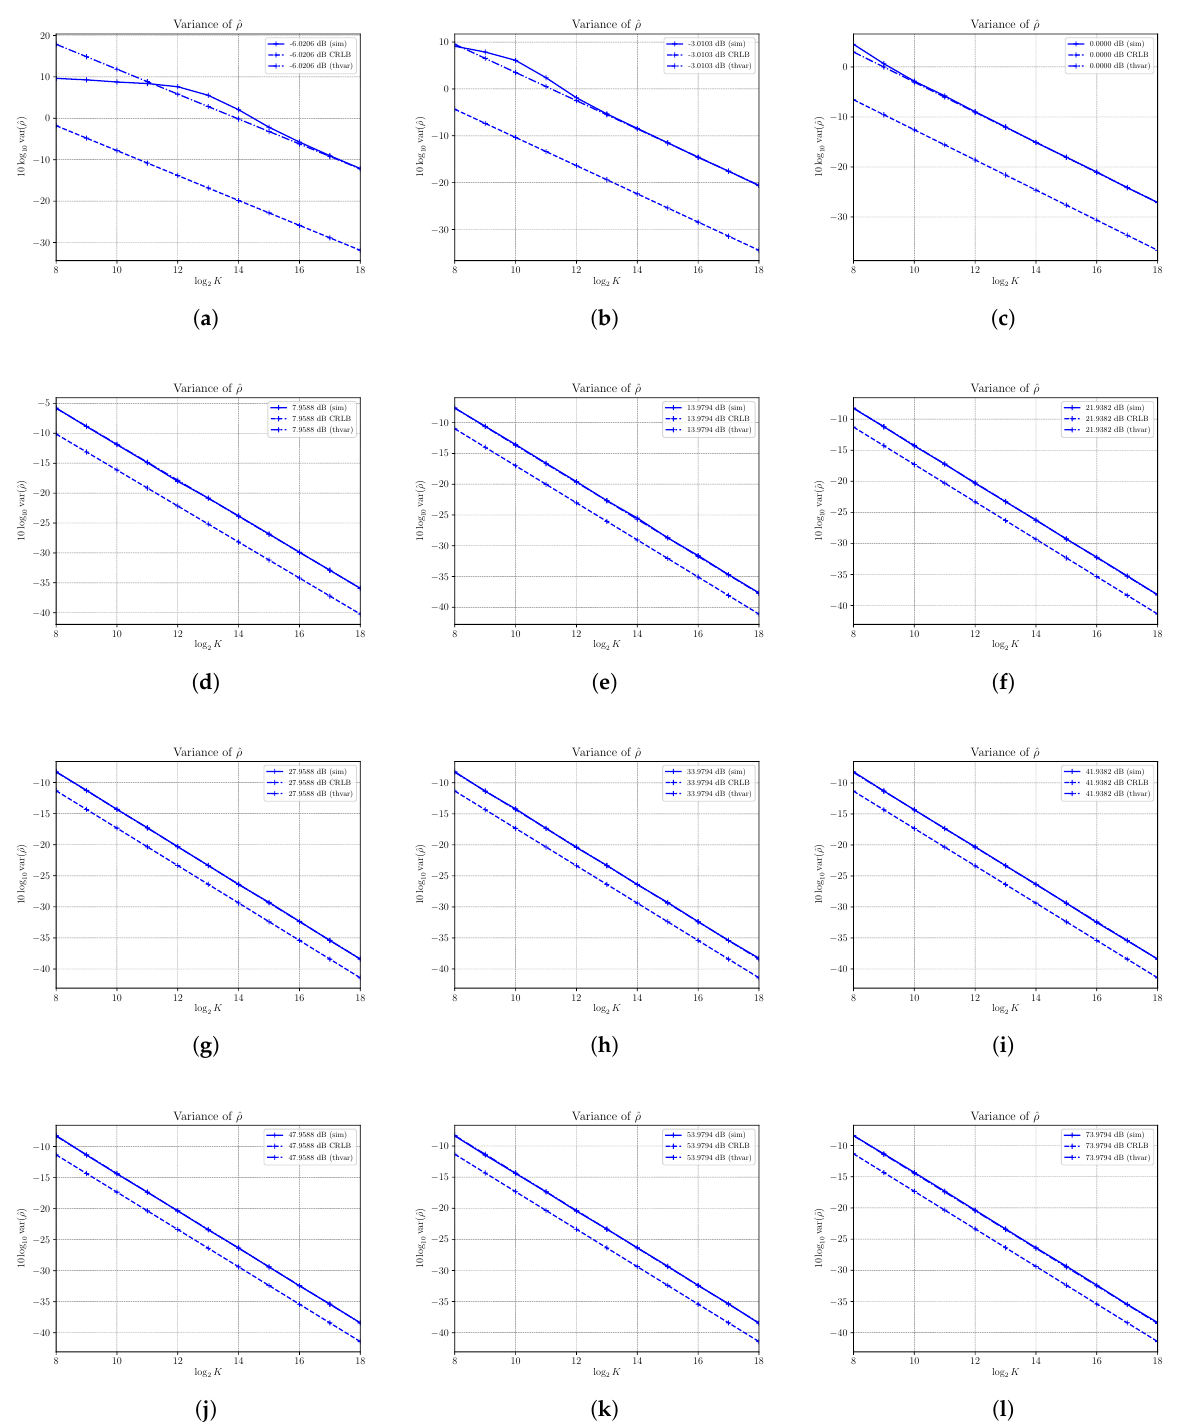
Figure 8. Asymptotic and estimated variances of the SNR estimator ˆ ρ versus the number of observations K . Each sub figure ( a – l ) shows results for a given nominal value of SNR obtained by changing the signal power S and with noise power N =